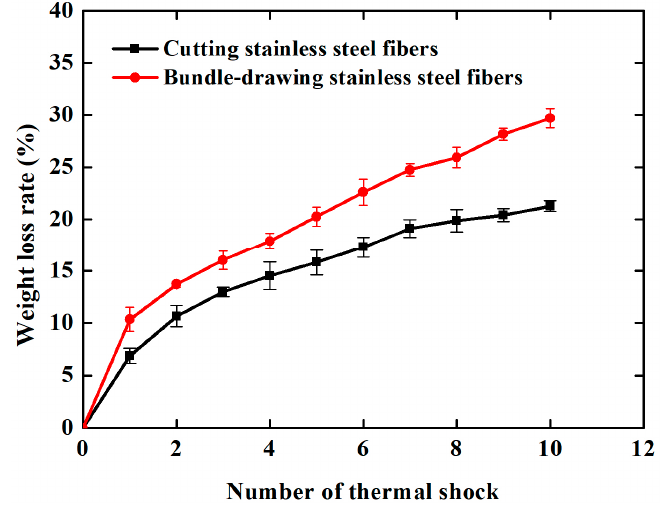
Figure 10. Weight loss rate-Number of thermal shock curves of samples .